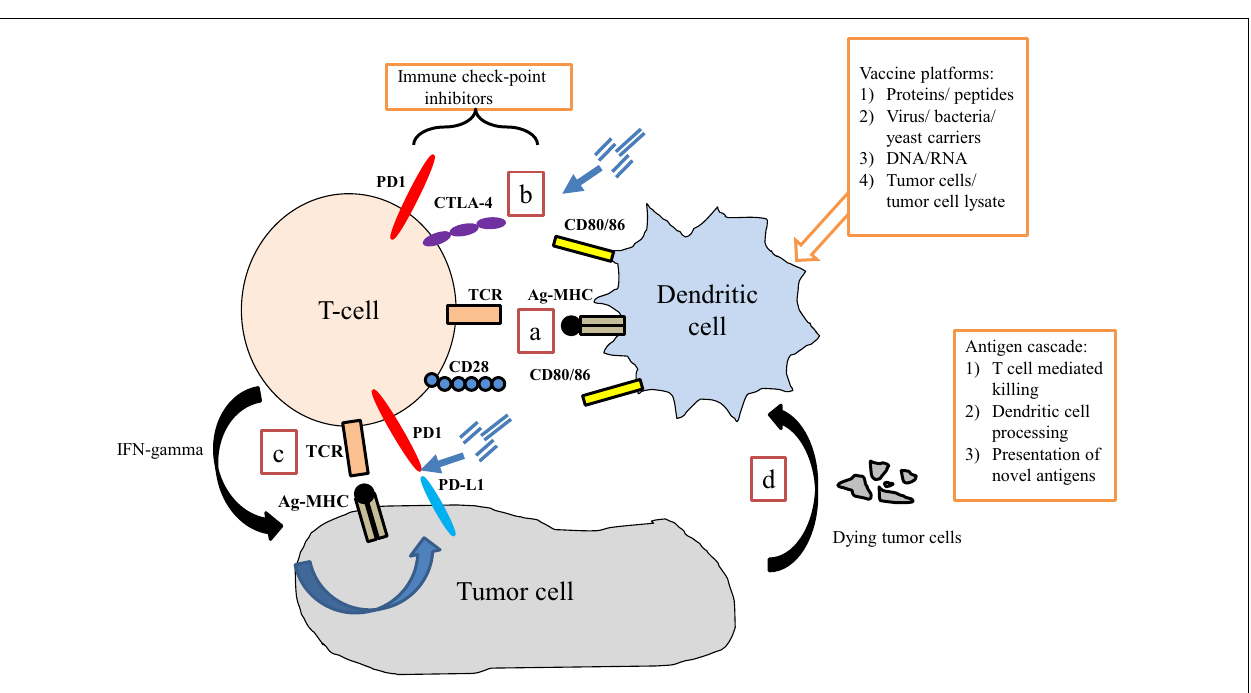
signaling,T cells up-regulate specificTCRs and produce interferon-gamma (IFN- γ ), which induces tumor cells to express programed death receptor 1 ligand (PD-L1), perhaps making it a therapeutic target. (d)Tumor cell destruction results in debris that is engulfed by APCs (including dendritic cells), processed, and presented back toT cells.This process is the basis for an immunotherapy-induced process known as antigen-cascade/antigen spreading.